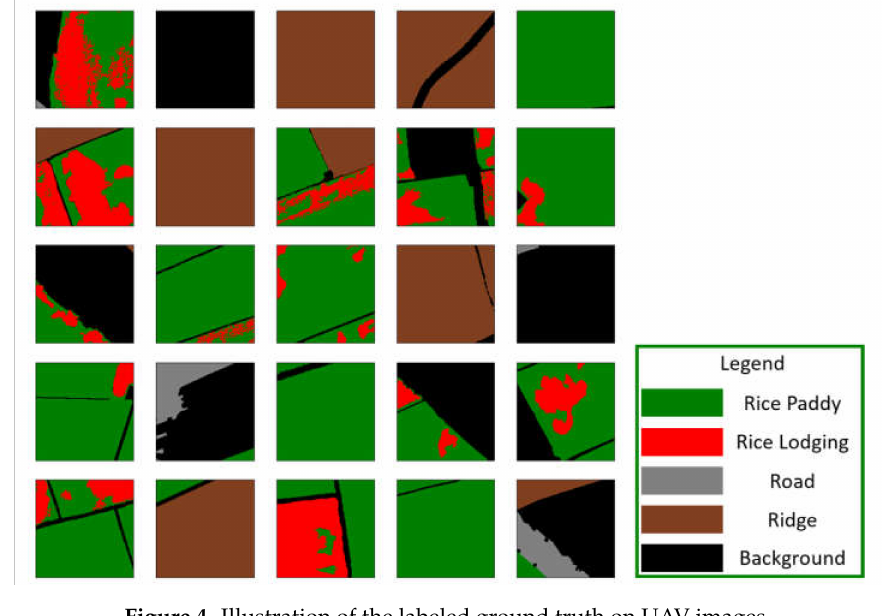
Figure 4. Illustration of the labeled ground truth on UAV images.